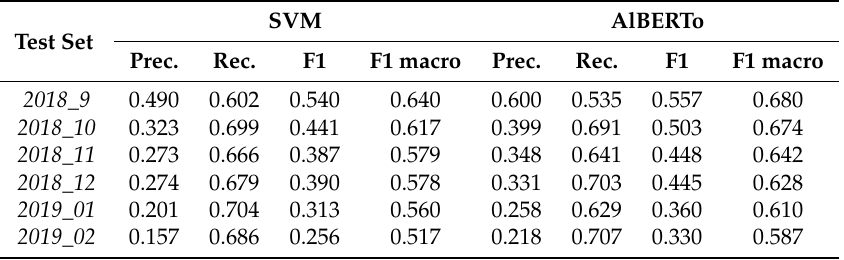
Table 4. Numerical results of the evaluation of the model trained on Sliding Window (no Haspeede+) dataset. SVM AlBERTo Test Set Prec. Rec. F1 F1 macro Prec. Rec.